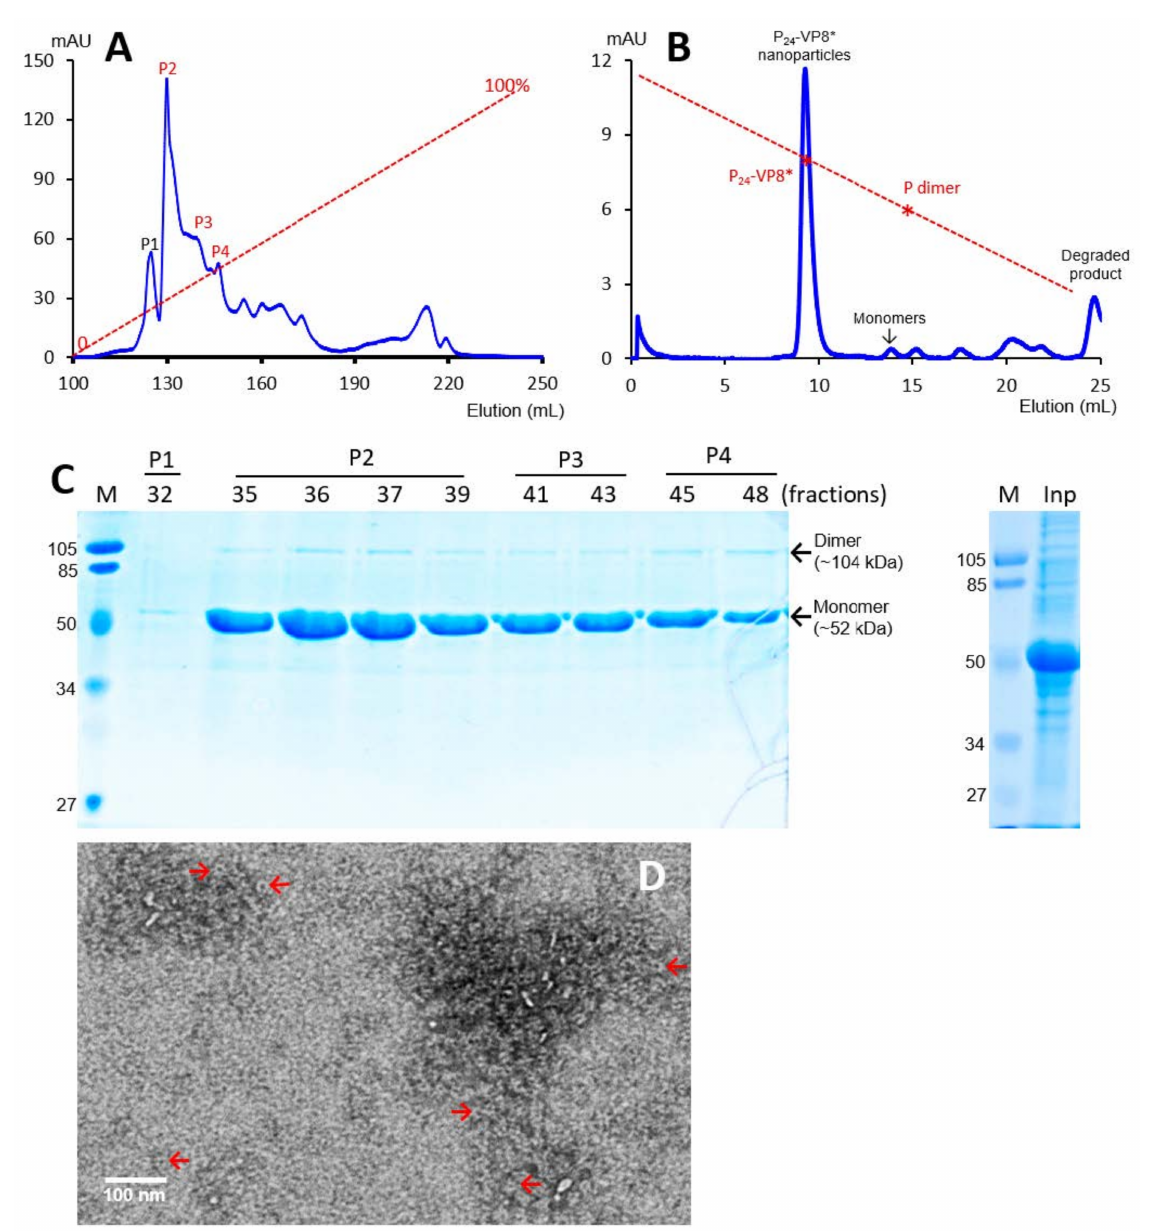
Figure 2. Production, purification, and characterization of the P-VP8* P[4] proteins. ( A ) A typical elution curve of an anion exchange chromatography of the (NH 4 ) 2 SO 4 -precipitated P-VP8* P[4] proteins, showing elution peaks of P2, P3, and P[4] containing major P-VP8* P[4] proteins. The Y-axis shows A280 absorbances (mAU), while the X-axis indicates elusion volume (mL). The red dashed line shows the linear gradient increase of the elution buffer B (0–100%). ( B ) A typical elution curve of a gel-filtration chromatography of the ion exchange-purified P-VP8* protein from P2 of ( A ) through a size exclusion column. The major P 24 -VP8* nanoparticle elution peak and the minimal monomer peak are indicated. The two elution peaks were calibrated using the previously made P 24 -VP8* P[8] nanoparticles (~1.2 mDa) [15] and P dimers (69 kDa) [43] with their elution positions shown by star symbols on a red dashed line. The Y- and X-axes are the same as in ( A ). ( C ) SDS-PAGE showing the proteins of the major elution peaks and fractions of the purified P-VP8* P[4] proteins (left) and the (NH 4 ) 2 SO 4 -precipitated proteins as input proteins (right, Inp). M, prestained protein standards with indicated molecular sizes in kDa. ( D ) An EM micrograph of the P-VP8* (4) proteins from the major peak of ( B ) showing typical P 24 -VP8 nanoparticles